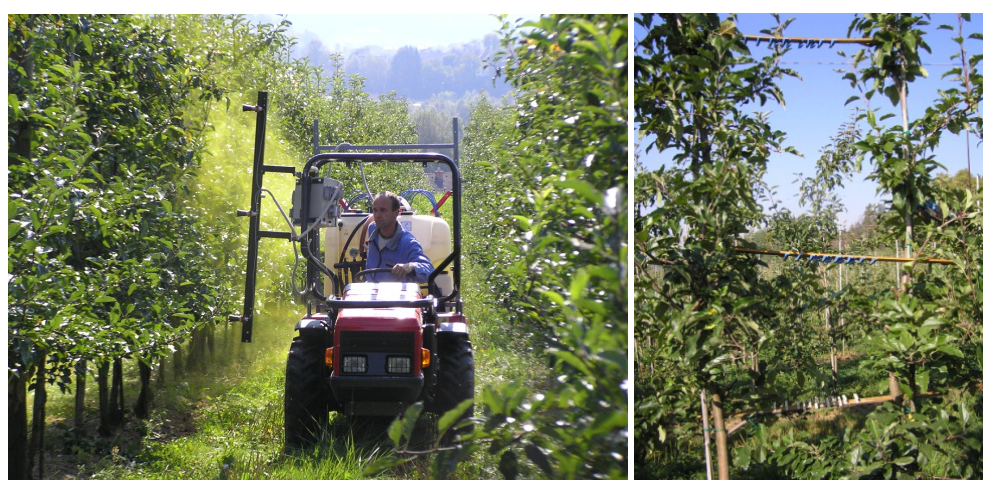
Figure 6. A prototype sprayer during the experiment in the orchard ( left ), detail with measuring positions on the tree ( right